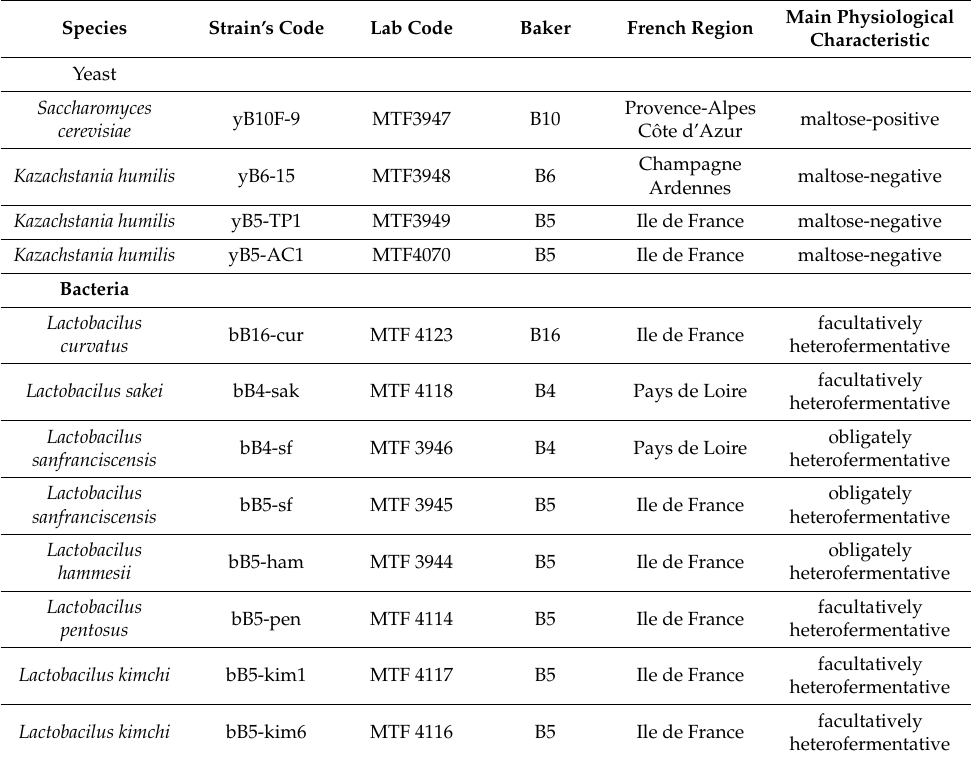
Table 1. Collection of